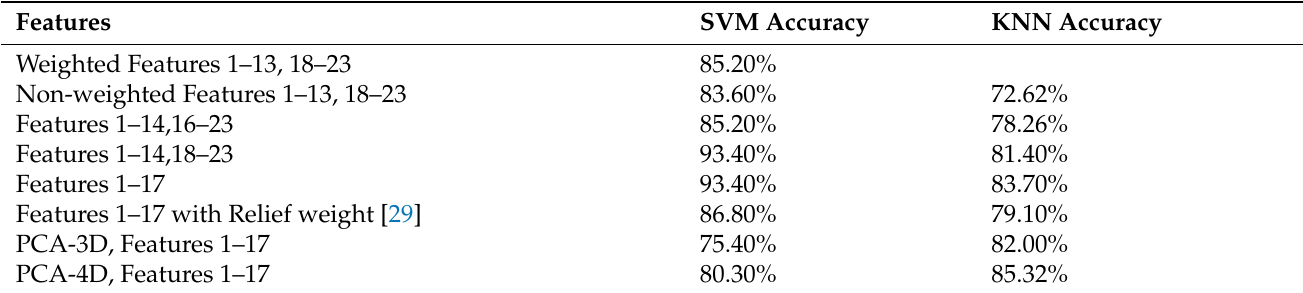
Table 2. SVM and KNN accuracy results.